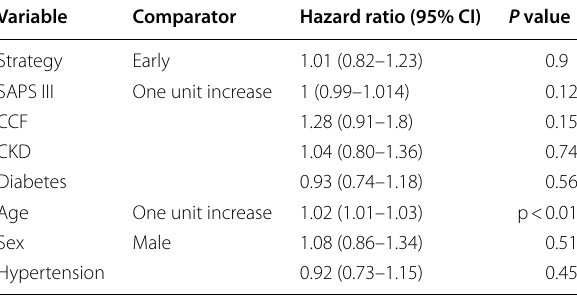
Table 2 Cox multivariate model for long‑term mortality from randomization